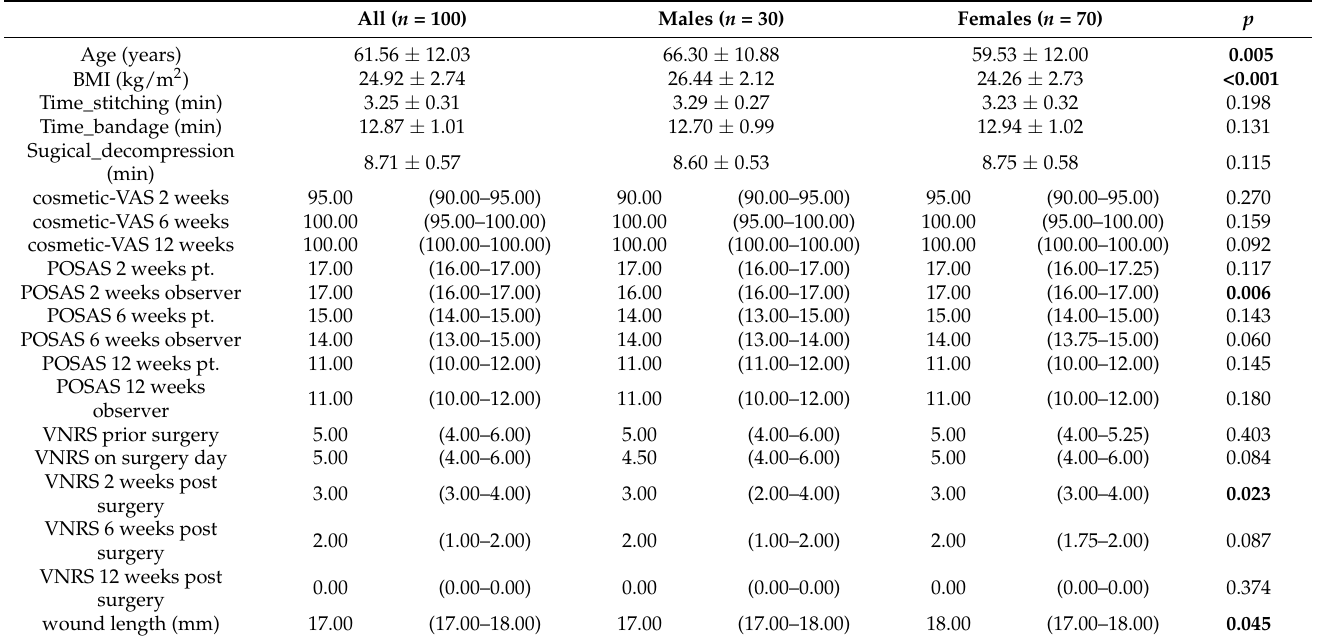
Table 1. Subjects’ clinical presentations with surgical times and outcomes. Data are shown for the entire patient population as well as for the two subgroups; sex differences are calculated (Student’s t -test for independent samples or Mann–Whitney test for non-parametric data), and p -values for significant differences are bolded. Data are presented as the arithmetic mean ± standard deviation, or median (interquartile range) for non-parametric variables.